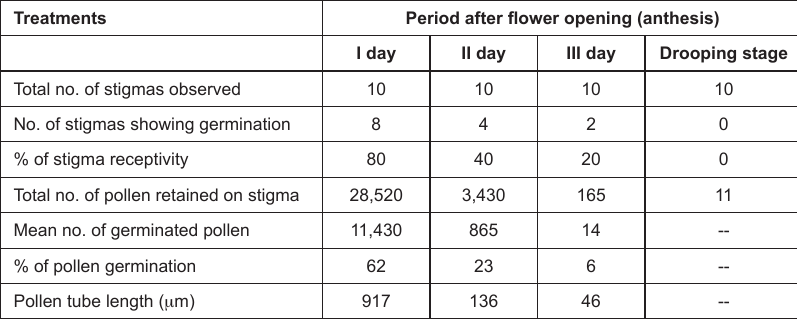
Table 2. In vivo pollen germination of Impatiens cuspidata Treatments